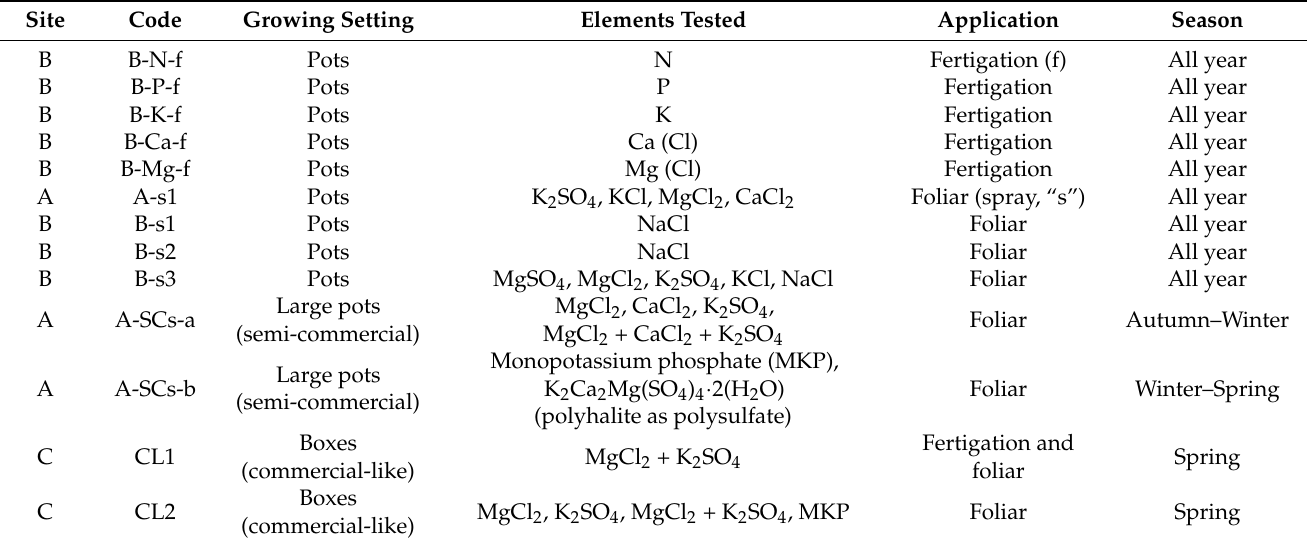
Table 1. Experimental setup, factors tested, application methods, and growing